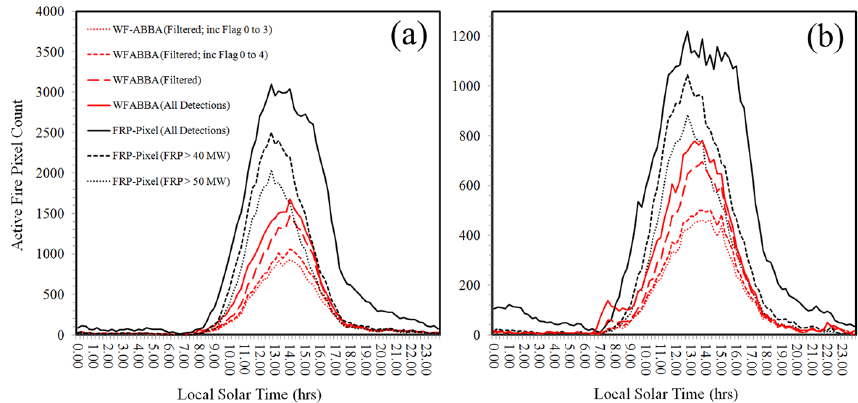
Figure 18. Comparison between FRP-PIXEL product active fire detections made across Southern Africa (the LSA SAF SAfr region; Fig. S1), along with those made simultaneously by the WF-ABBA SEVIRI fire product (Gonzalo et al., 2009; http://wfabba.ssec.wisc.edu/). Dates are (a) 2 August 2014 and (b) 31 August 2014, and both are shown in terms of local solar time of detection. For the FRP-PIXEL product, three active fire time series are shown: all detections, and those only from fire pixels with FRP>40MW and >50MW, since it is known that significant undercounting of active fire pixels occurs around these limits (i.e. below threshold H L in Fig. 15). For the WF-ABBA active fire detections, four versions of the data are shown: all active fire detections, the WF-ABBA “filtered” detections where SEVIRI pixels only detected an active fire once during 24h are removed, and the filtered detections keeping only the higher possibility fires (WF-ABBA flags 0–3), and high and medium possibility fires (WF-ABBA flags 0–4). Details of the WF-ABBA flags can be found at www.ssd.noaa.gov/ PS/FIRE/Layers/ABBA/abba.html. On both days and at all time slots, the full FRP-PIXEL product active fire record (black line) detects substantially greater numbers of active fire pixels than the full WF-ABBA record (red line). Roberts et al. (2015) go on to further compare the performance of these two products to MODIS active fire